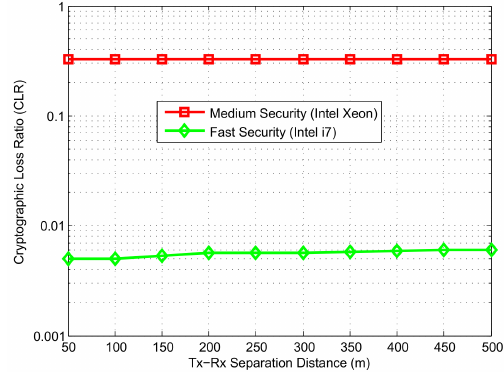
Figure 18. Cryptographic Loss Ratio (CLR) at different levels of security (Logarithm scale at y -axis).